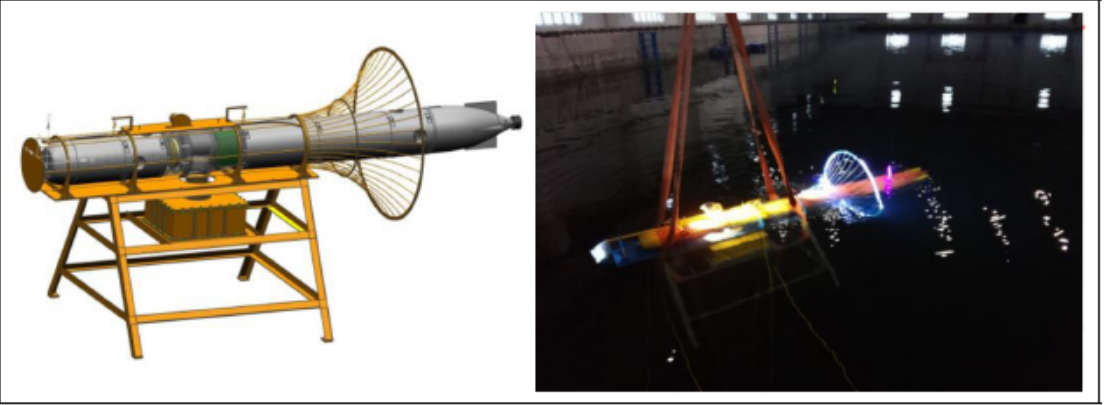
Figure 28. Experimental demonstration of Torpedo AUV Prototype[146]. Table 8. Comparison of existing docking stations [123].